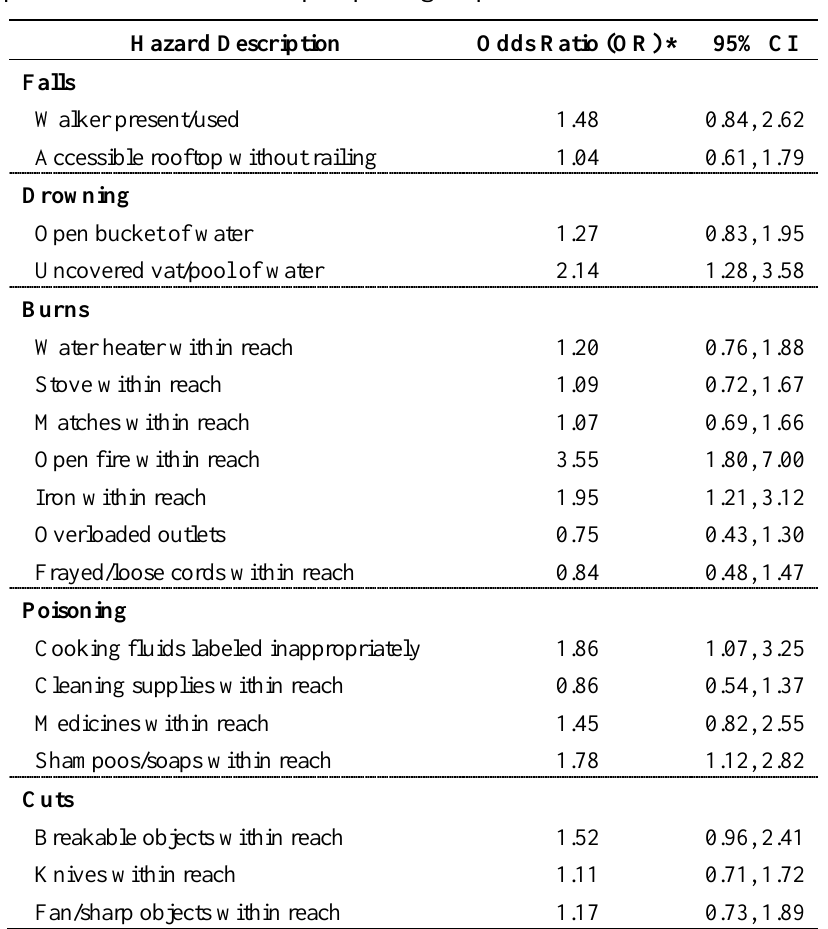
Table 3. Odds of change from presence to lack of specific hazards in the in-home tutorial group as opposed to the educational pamphlet